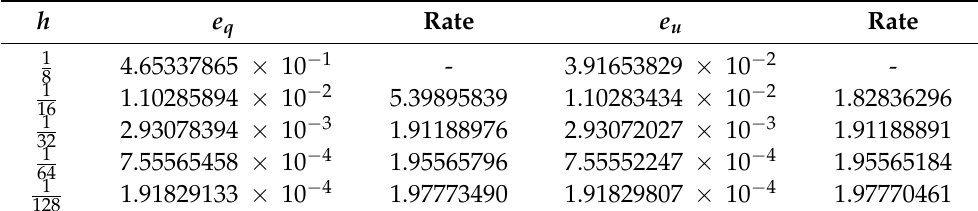
Table 12. Error e q and e u for the time convergence rates with α = 0.7.